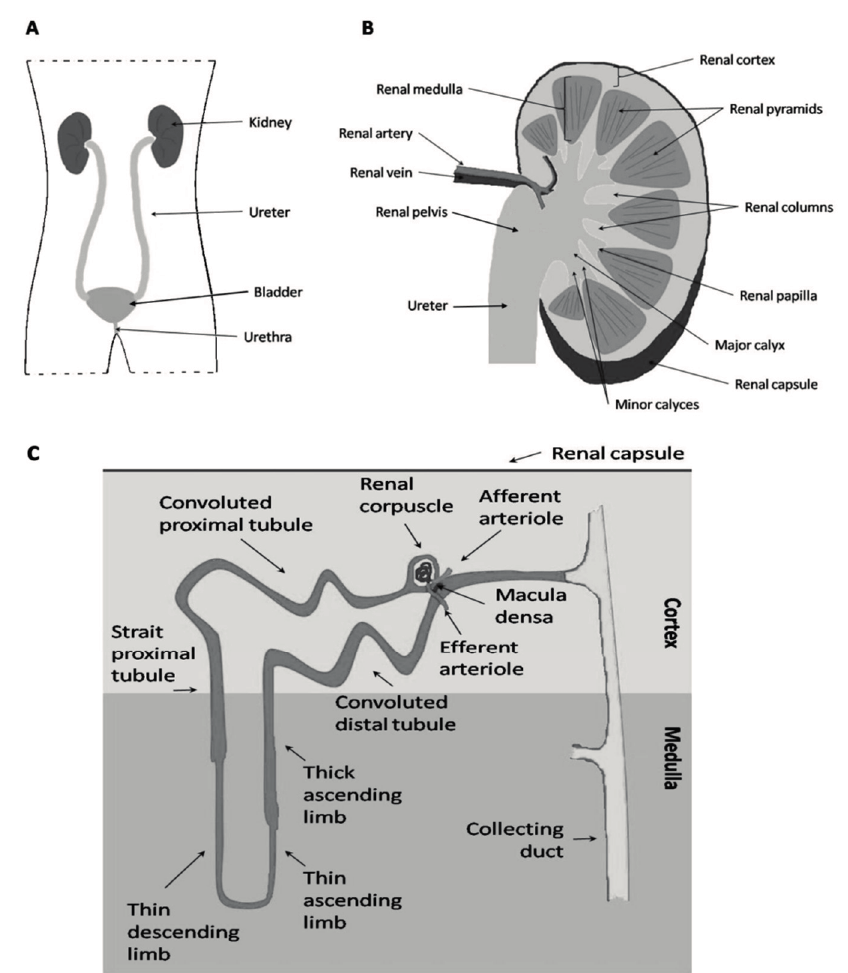
Figure 1. Structure and organization of the kidney. ( A ) The location of the kidney in the body; ( B ) Schematic cross section of the kidney to demonstrate the overall structure; ( C ) A closer look gives an insight on the nephron structure and orientation within the kidney with a clear distinction between the cortex and the